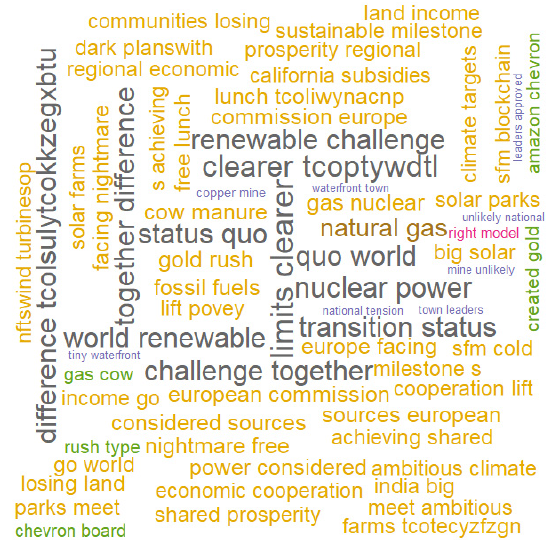
Figure 6. Wordcloud by bigrams period 1.